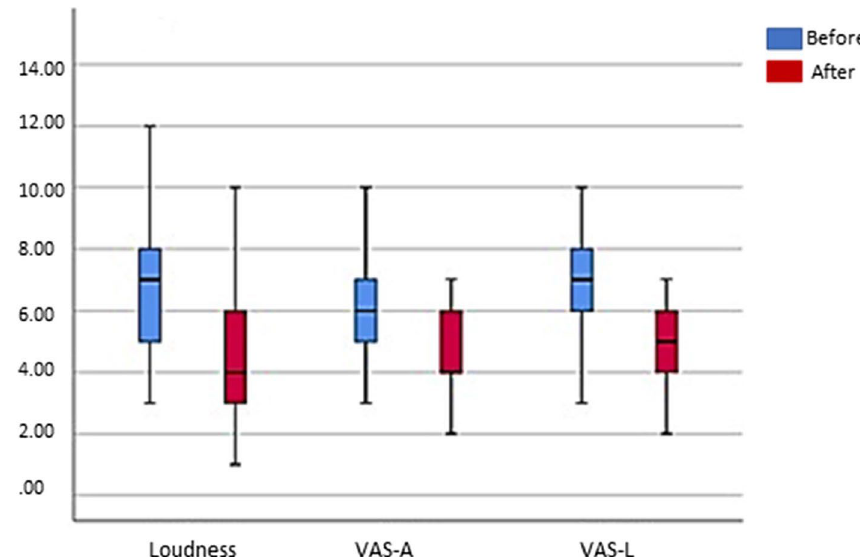
Fig. 3 The boxplot curve of loudness, VAS-L and VAS-A measurements in tinnitus patients before and after BB